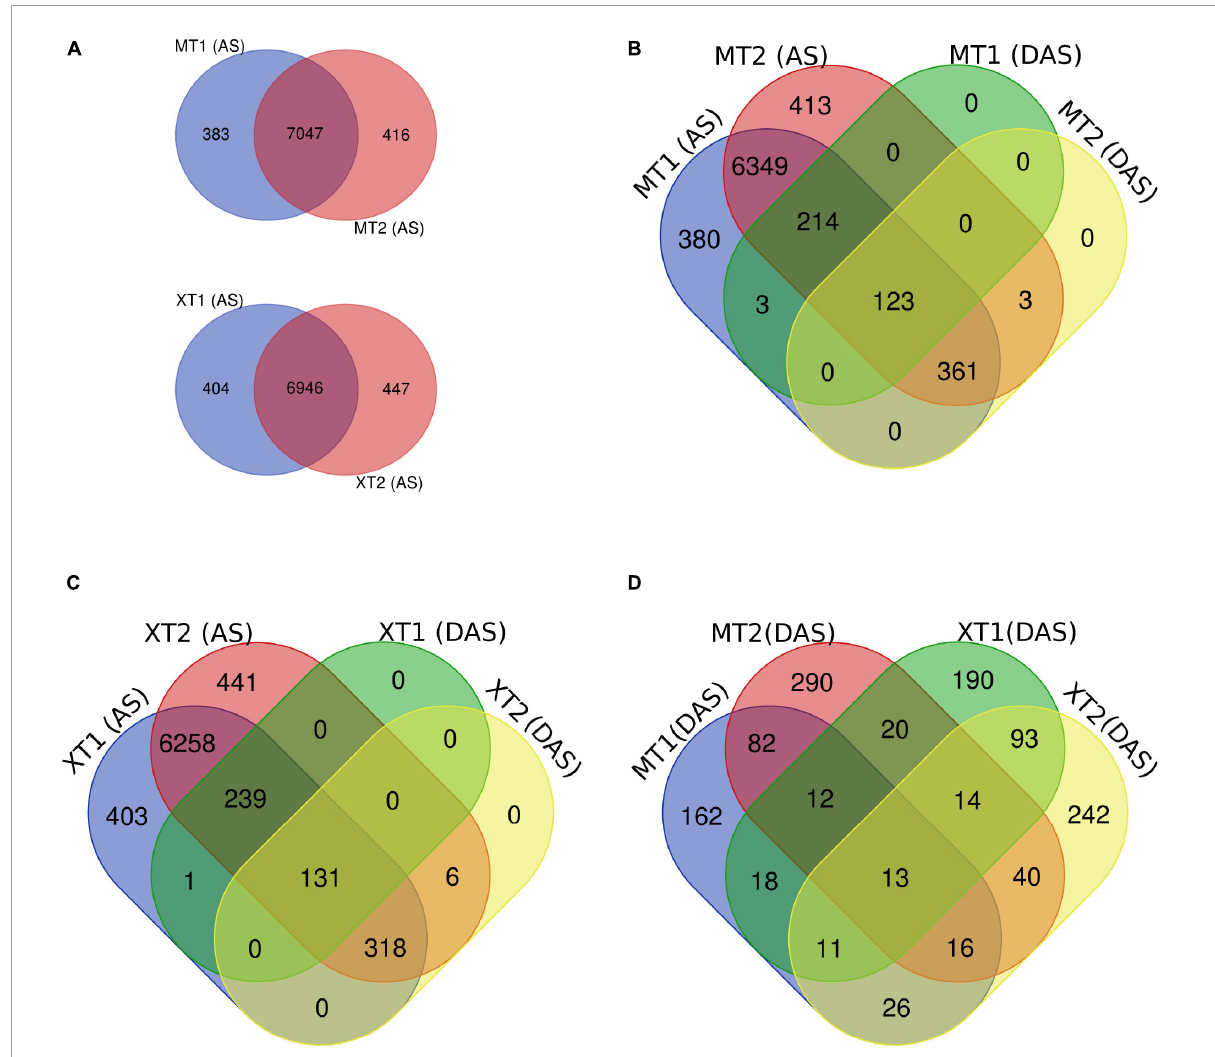
FIGURE2 Overlap of differentially alternative spliced (DAS) events with a total of unique AS sites in Meixiangzhan-2 (M) and Xiangyaxiangzhan (X) cultivars in response to different levels of Zn treatment. (A) Venn diagram representing the overlap of unique AS sites in response to low (T1) and high dose (T2) of Zn in both cultivars. (B,C) Venn diagram representing the overlap between unique AS sites and DAS events in response to different doses of Zn in both cultivars. (D) Venn diagram representing the overlap of DAS sites in both cultivars in response to different doses of